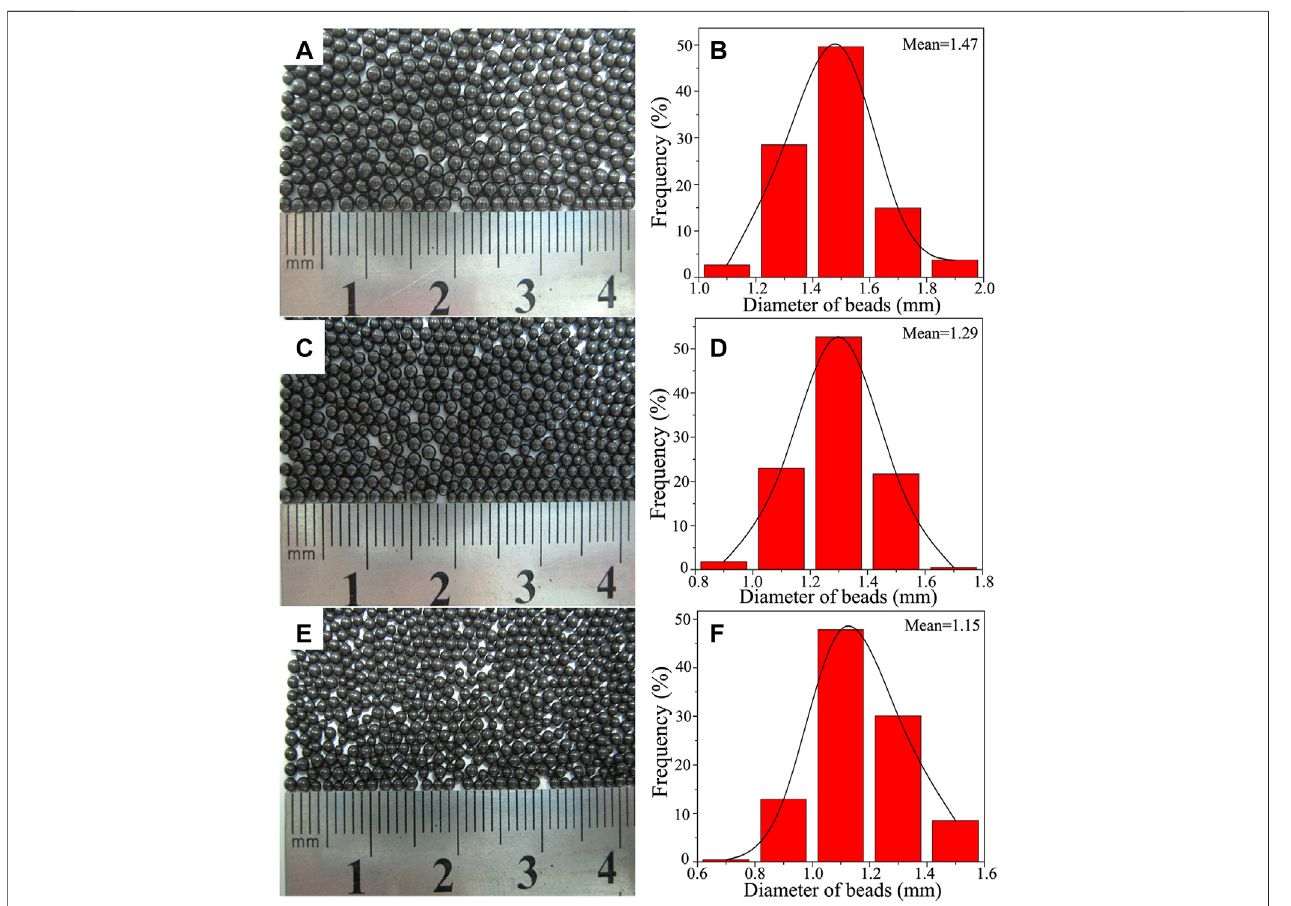
FIGURE 6 | Optical photography showing the macromorphology of PS/Fe 3 O 4 composite beads with the OA-Fe 3 O 4 content of 2 wt% obtained at different stirring speeds: (A) 180 rpm, (C) 210 rpm, and (E) 240 rpm. Panels (B) , (D), and (F) are the histograms showing the size distribution of panels (A) , (C), and (E) , respectively.